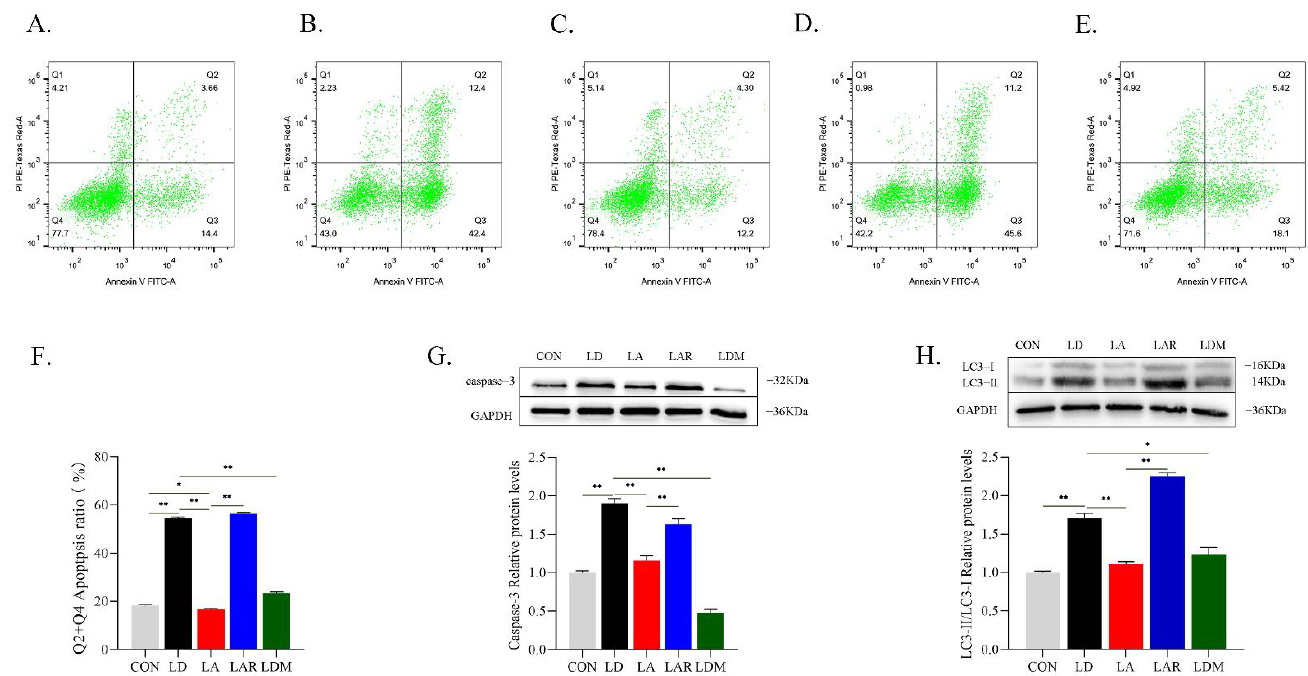
Figure 8. mTORC1 signaling pathway is involved in the regulation of apoptosis and autophagy by lysine. ( A ) CON; ( B ) LD; ( C ) LA; ( D ) LAR; ( E ) LDM; ( F ) apoptosis rate (%); ( G ) representative images of caspase-3 protein expression levels with Western blotting; ( H ) representative images of LC3-II/LC3-I protein ratio with Western blotting. * p < 0.05, ** p < 0.01. The data shown represent mean ± SEM of three independent experiments ( n = 3).